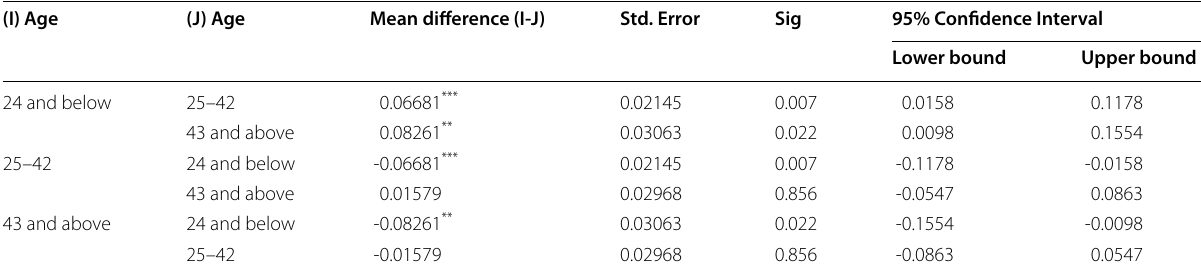
Table 5 ANOVA for employment sector and COVID-19 lifestyles